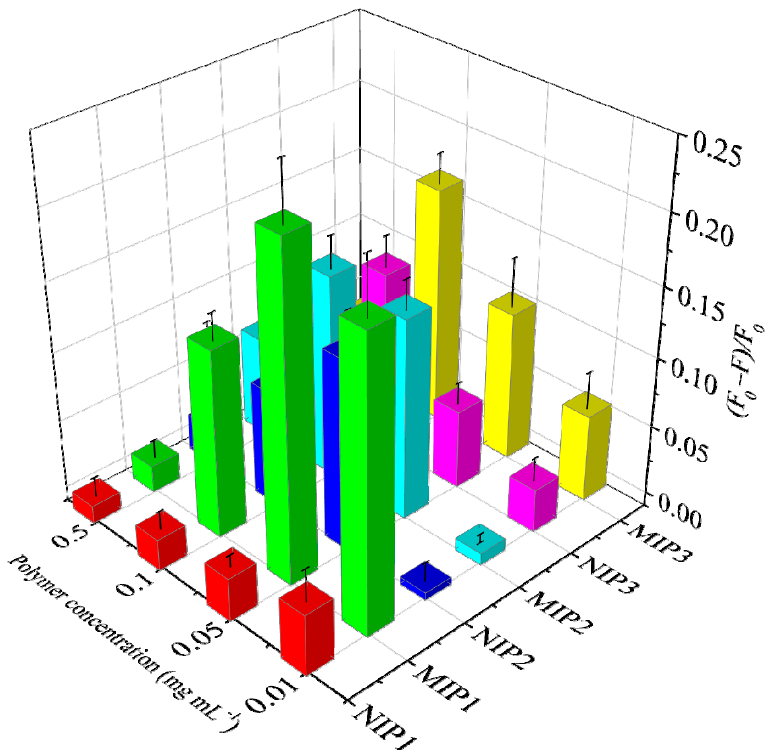
Figure 2. Fluorescence response of the MIPs (MIP1, MIP2 and MIP3) and NIPs (NIP1, NIP2 and NIP3) to glyphosate (10 µ M) at different concentrations.